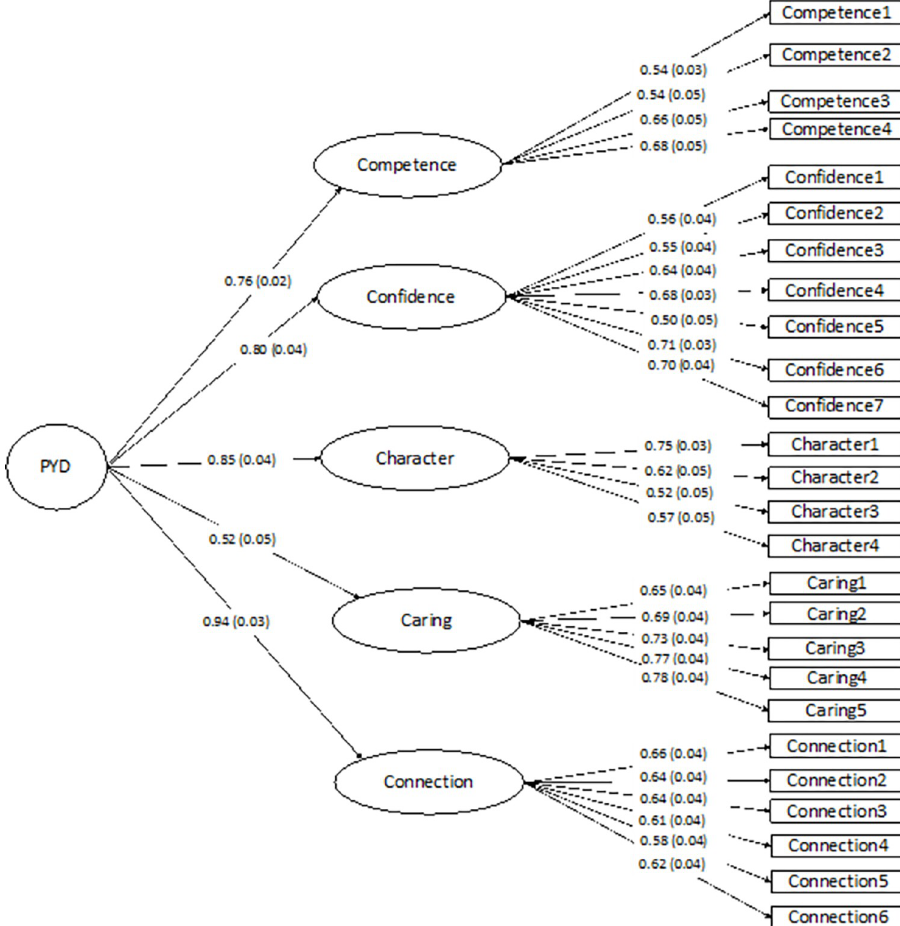
Fig 1. PYD measurement model with standardized parameter estimates.